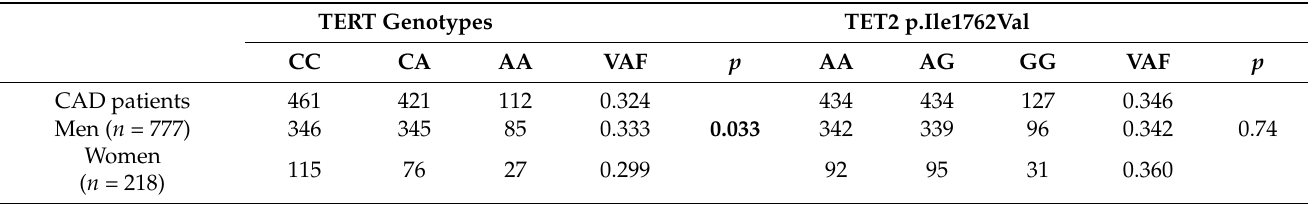
Table 2. Frequencies of the TERT rs7705526 and TET2 rs2454206 genetic variants in CAD patients, stratified by gender.